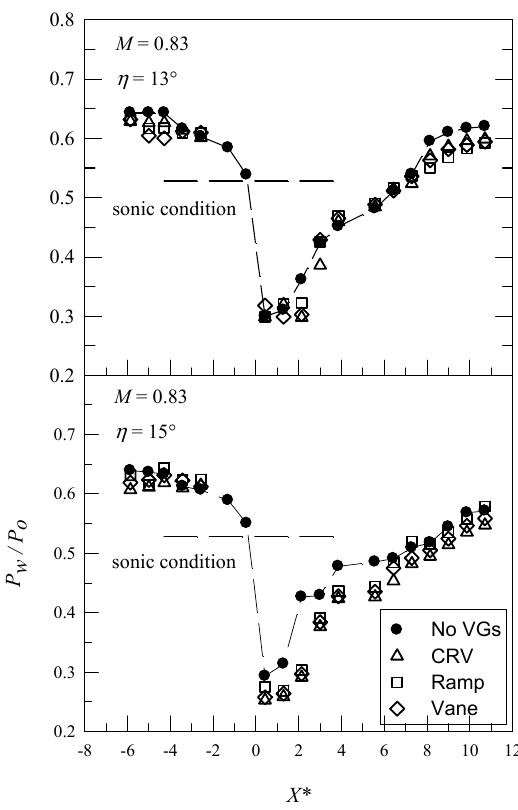
Figure 8. Mean surface pressure distributions for M = 0.83. For η = 13 ◦ , the minimum value for P w / P o , ( P w / P o ) min , occurs at X * = 0.43, but not for the Vane MVGs ( X * = 1.29). For the baseline case with η = 15 ◦ , there is a distinctive kink at X * ≈ 2, which indicates SIBLS [23]. The pressure plateau moves downstream if MVGs are used. The location for ( P w / P o ) min moves downstream because of trailing-edge expansion induced by MVGs [27]. P w / P o has a lower amplitude downstream of the